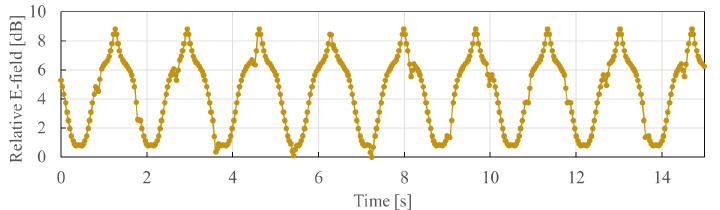
Figure 10. Body movement waveform separated using SWT when the body movement frequency is 0.6